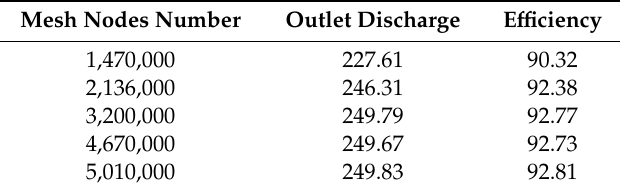
Table 2. Mesh independence at σ = 0.12 with the present simulation method.